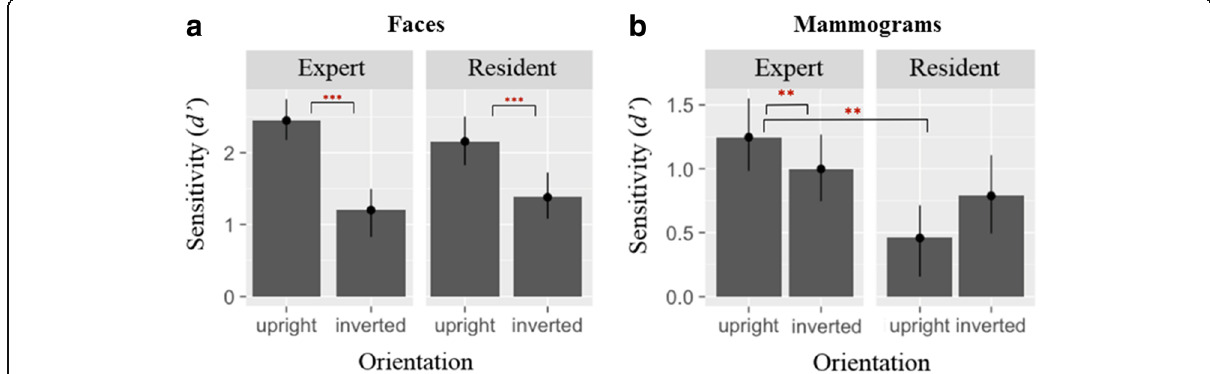
Fig. 3 Performance d ’ scores on forced-choice task for experienced and novice radiology residents for a face stimuli and b mammogram stimuli. Error bars represent 95% CI for within-subject measures. ** p < 0.01. *** p < 0.001